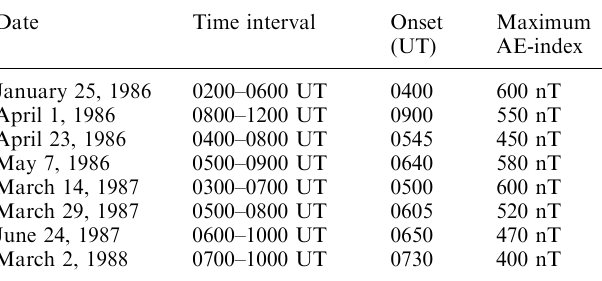
Table 3. A list of the substorms selected to estimate the velocity of the azimuthal expansion of the SCW